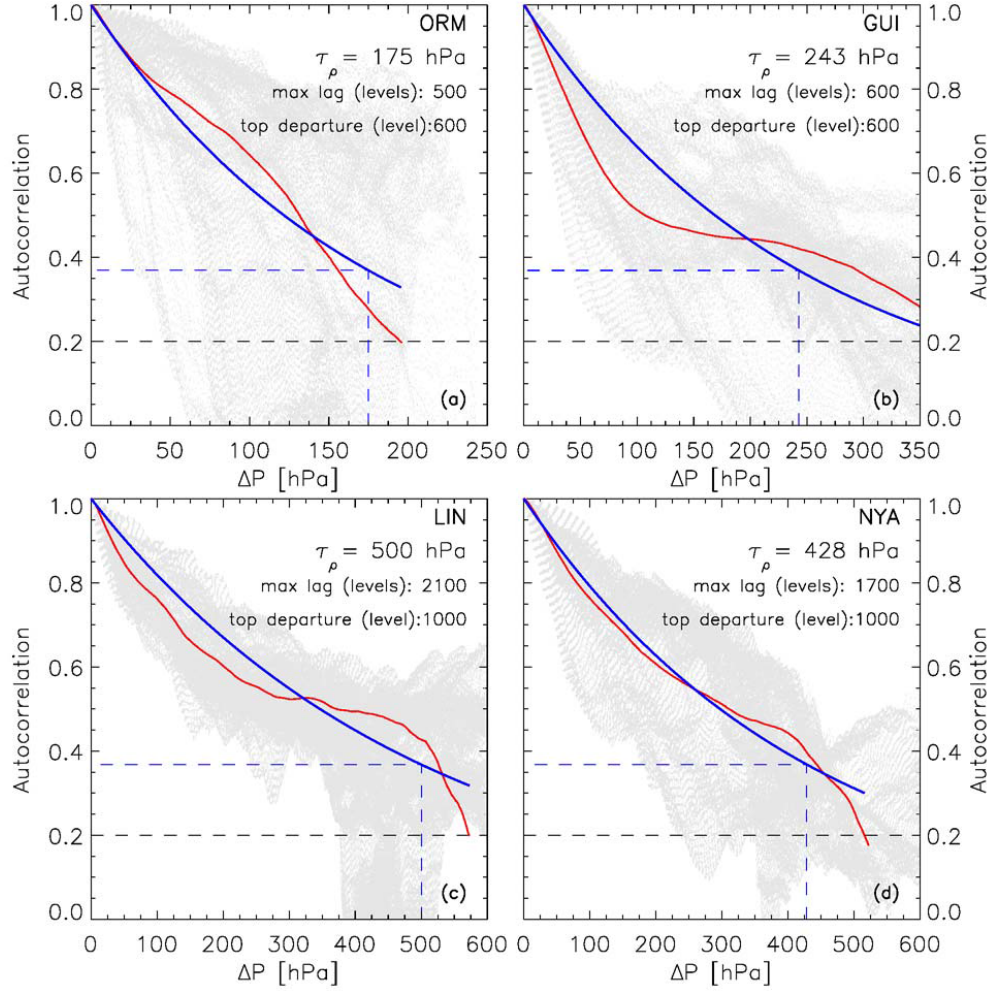
Figure 3. Results of the empirical autocorrelation exponential decay model applied of the four sites studied and exponential autocorrelation pressure lag (see Sect. 3.2). The background grey lines are the autocorrelations ρ ij between a sub-sample of r i from all the available radiosoundings and the following r j , separated by the lag (cid:49)P = p i − p j . For each fixed lag, the departure levels i were sequentially shifted up to ρ ij = 0 . 2, with a maximum level such as the level + lag approximately reach the troposphere height where the content of water vapour